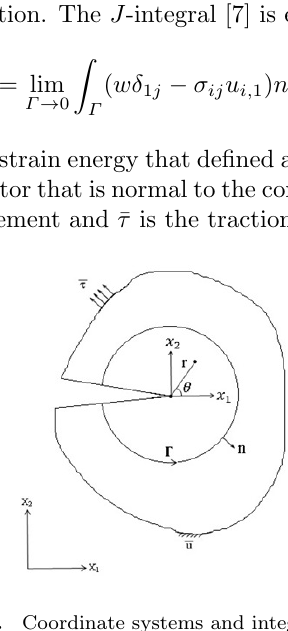
Figure 3. Coordinate systems and integration